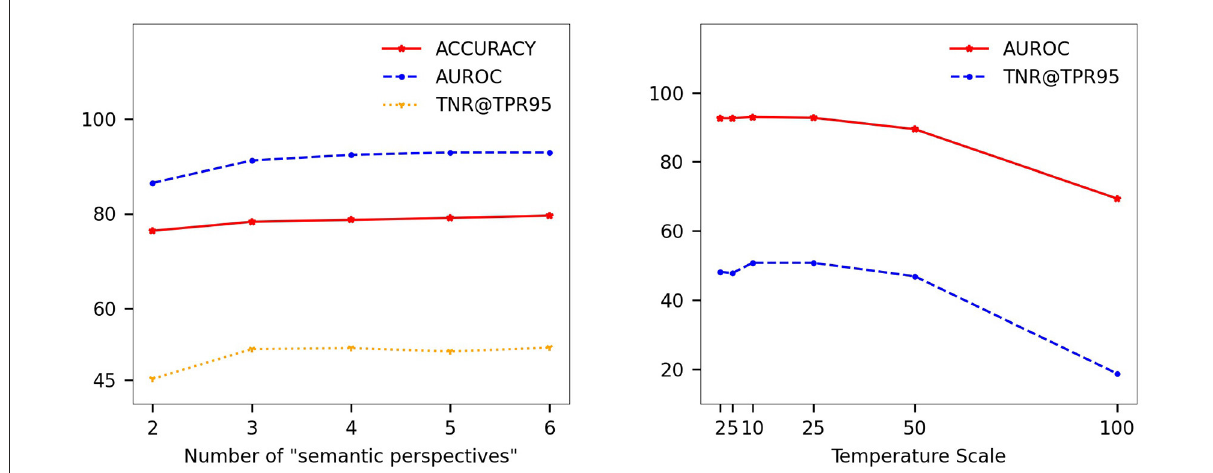
FIGURE3 Regarding the effect of three parameters on the model performance: the number of “semantic views,” and the temperature scaling coefficient. The ID and OOD data used in this experiment correspond to Cifar100 and Cifar10, and the skeleton network for feature extraction is ResNet. (Left) Selection of the number of “semantic perspectives.” (Right) Effect of different temperature scaling coefficients on the model.